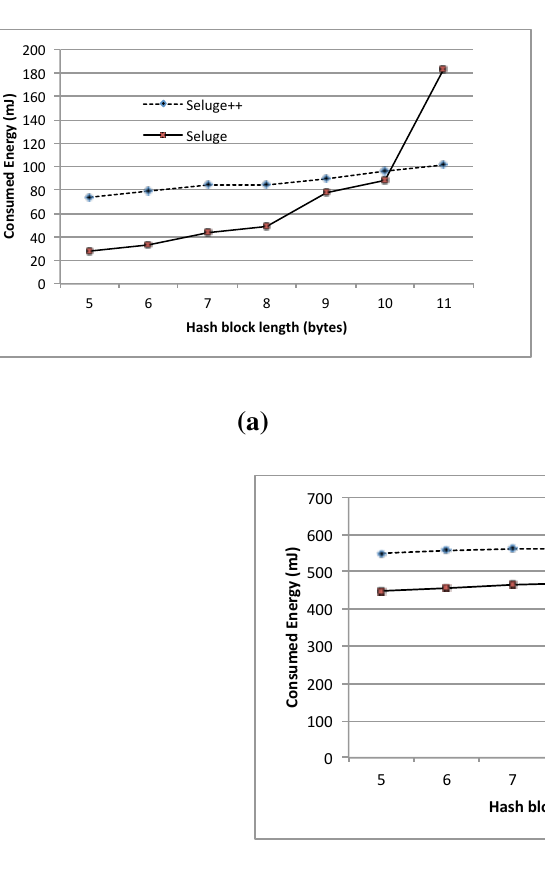
Figure 12. Comparison of the overall energy cost in the dissemination of 5-kb image data. ( a ) Initialization phase; ( b ) Data transmission phase; ( c )